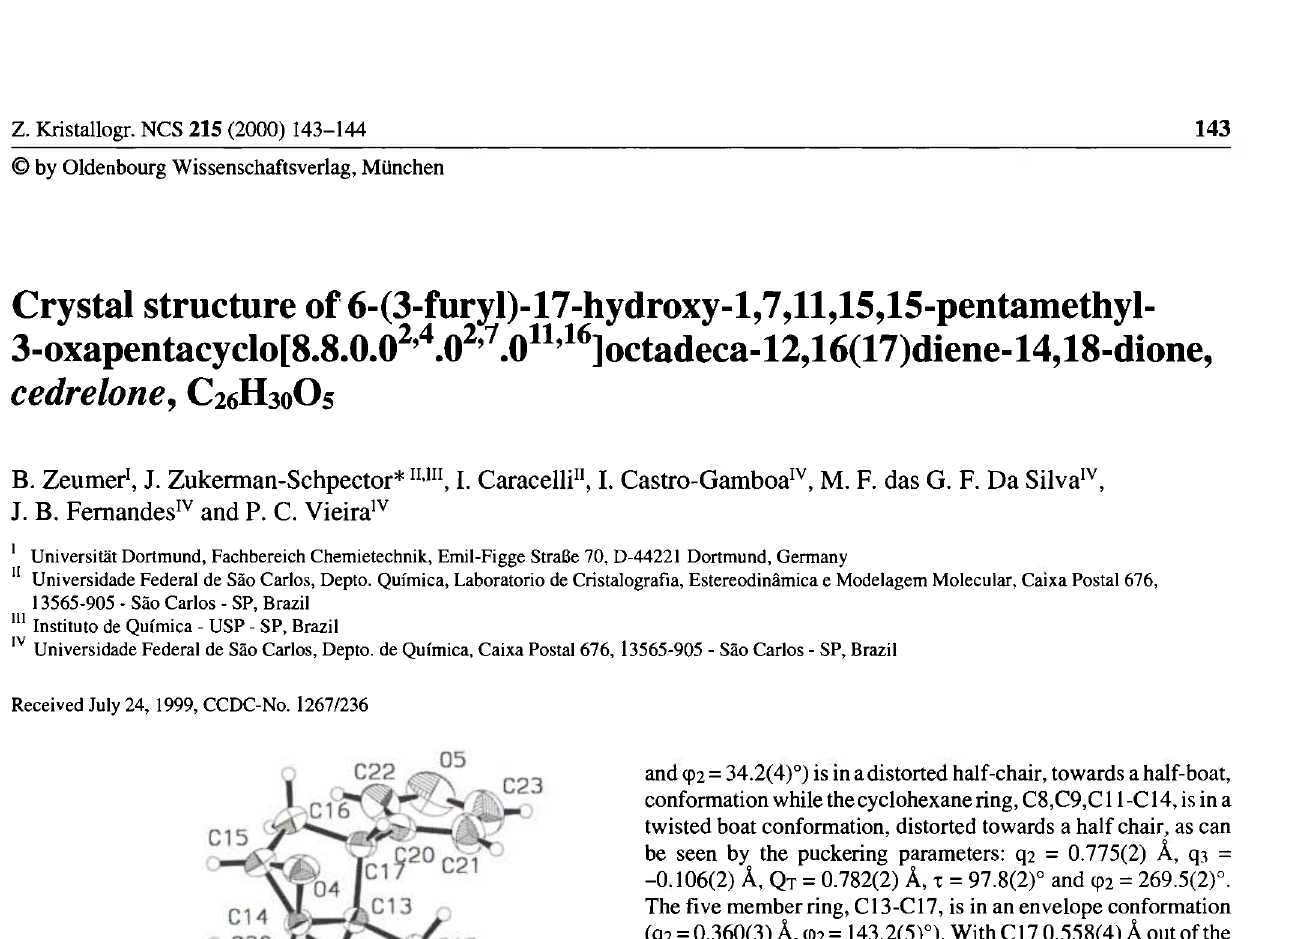
Table 1. Data collection and handling.